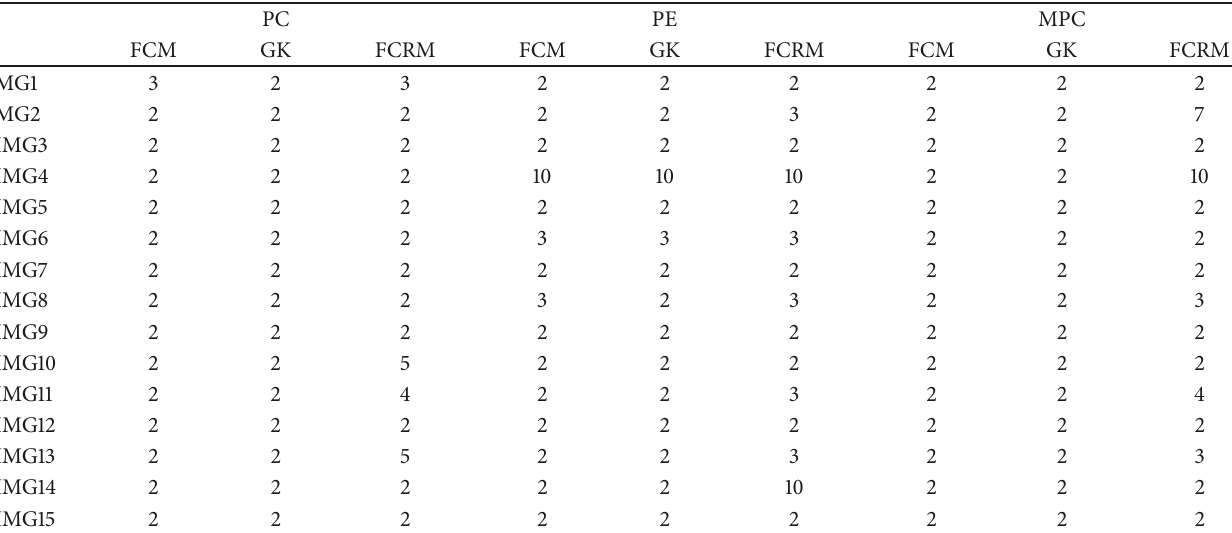
Table 6: Best cluster number of FCM, GK, and FCRM using PC, PE, and MPC.